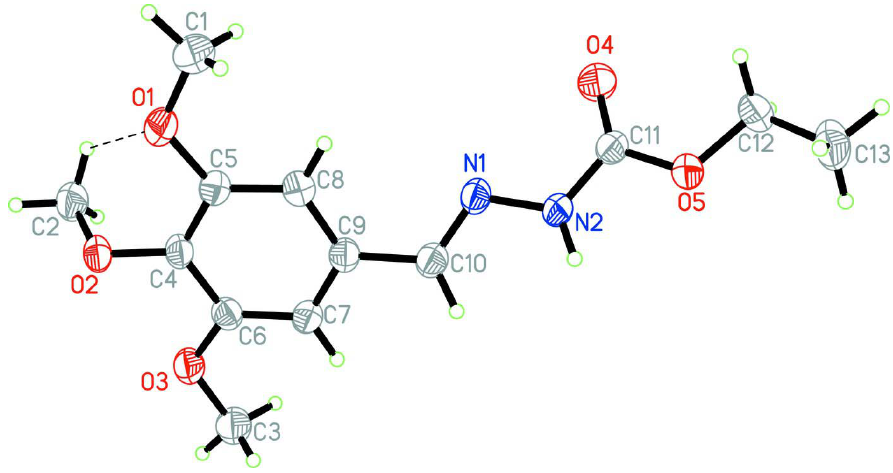
Figure 1 The molecular structure of (I), showing 40% probability displacement ellipsoids for the non-hydrogen atoms. The C— H···O interaction is shown as a dashed line.